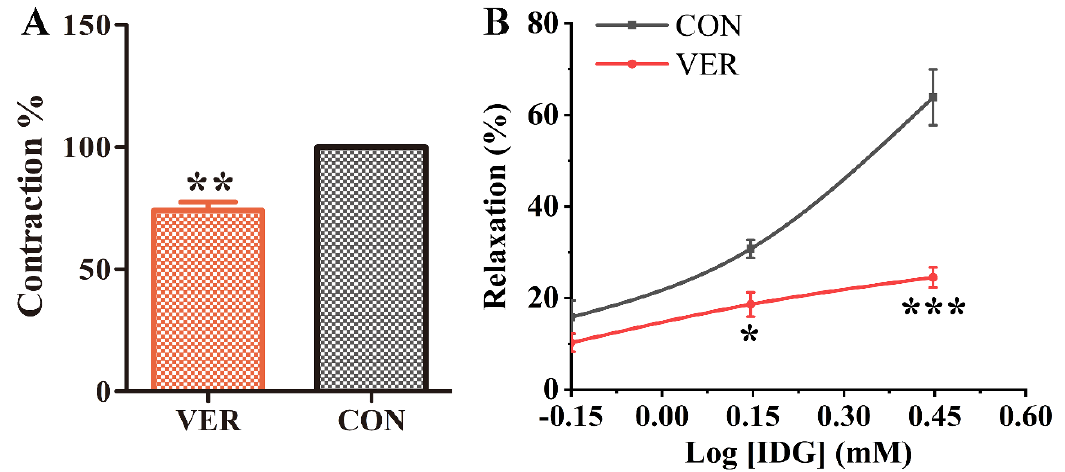
Figure 6. Effect of verapamil (VER) on the vascular relaxation of IDG. ( A ) In endothelium-denuded aortic rings contracted with NE before pre-incubation with or without VER (10 µ M), the maximum contraction of the CON group caused by NE (10 mM) was recorded as 100%. ( B ) Vasoconstriction occurred when IDG (0.7, 1.4, or 2.8 mM) was added. Statistical analysis was performed using two-way ANOVA; * p < 0.05, *** p < 0.001 vs. CON group.